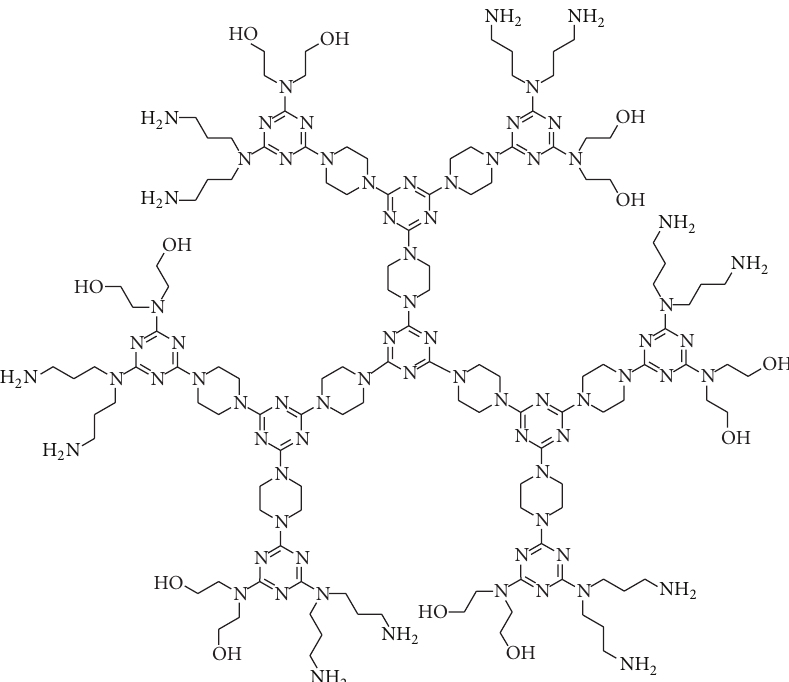
Figure 7: Triazine G2 dendrimers with terminal amine and hydroxyl